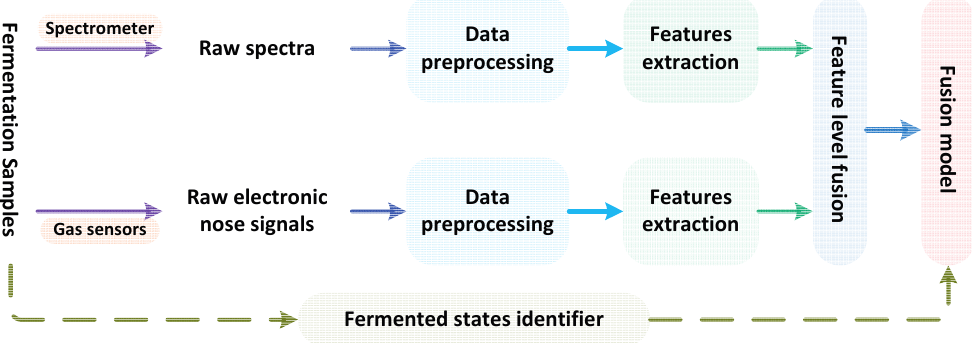
Figure 3. The structure of the intermediate-level fusion for monitoring of SSF of feed